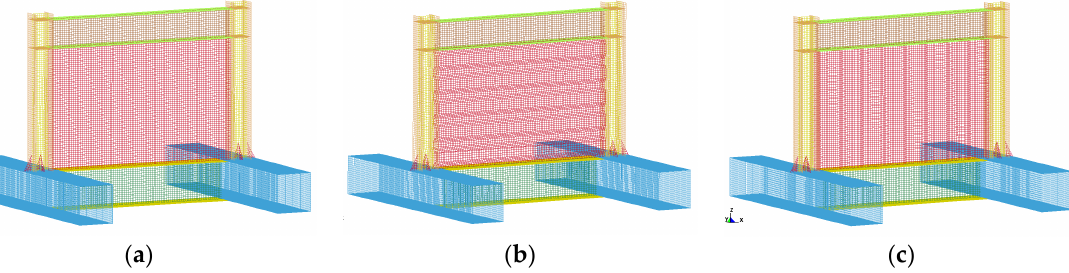
Figure 7. FEM of the walls with ( a ) flat, ( b ) horizontal corrugated, and ( c ) vertical corrugated steel plate.